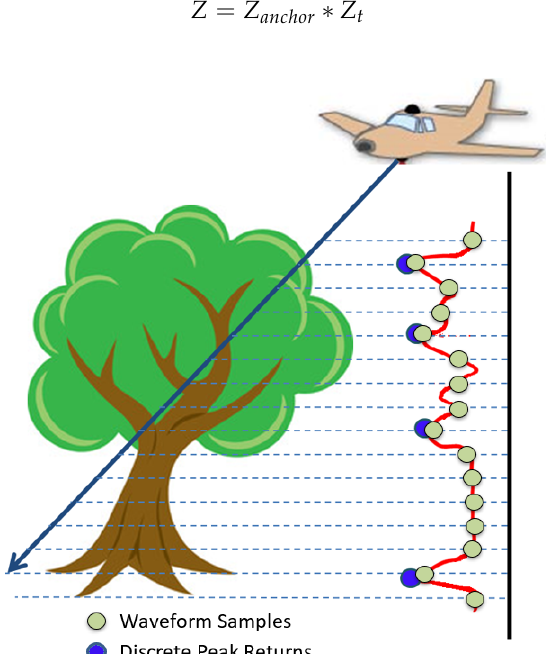
Figure 4. Illustration of how full-waveform LiDAR systems work. They emit a laser pulse and digitise the entire backscattered signal. Digitisation is done at equal time space intervals and the average distance between two coherent waveform samples is